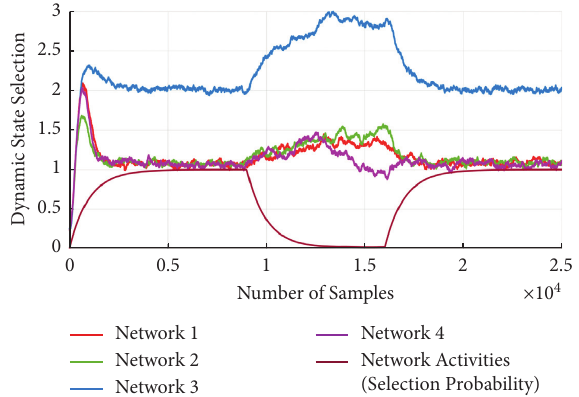
Figure 3: Effect of threshold on network connectivity for � 2 ) . sensitivity � 5 ( V thrl